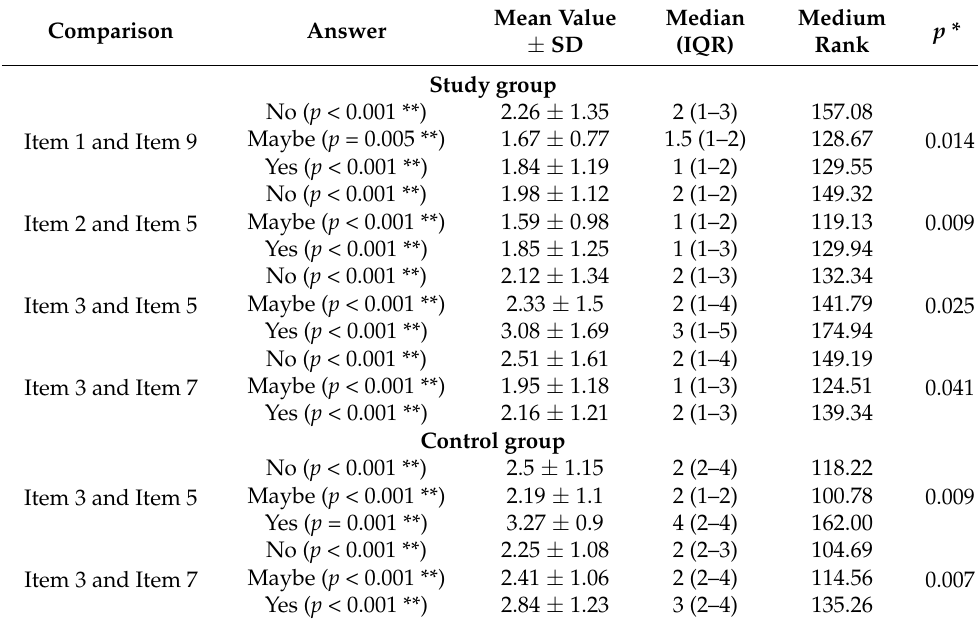
Table 8. Comparisons between various items.